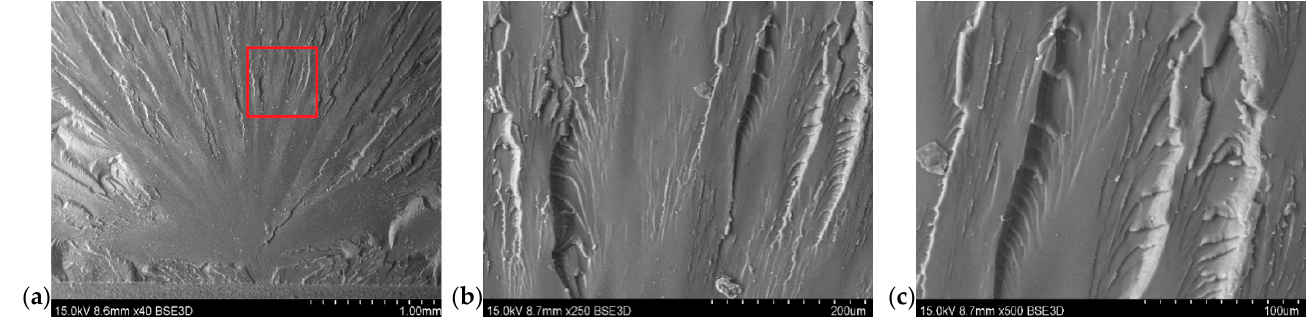
Figure 14. Fracture surface of pure resin material in SEM images. ( a ) Crack initiation zone with the marked area with further enlargement. ( b ) Fracture surface of neat resin ‐ magnification ×250. ( c ) Fracture surface of neat resin ‐ magnification ×500.